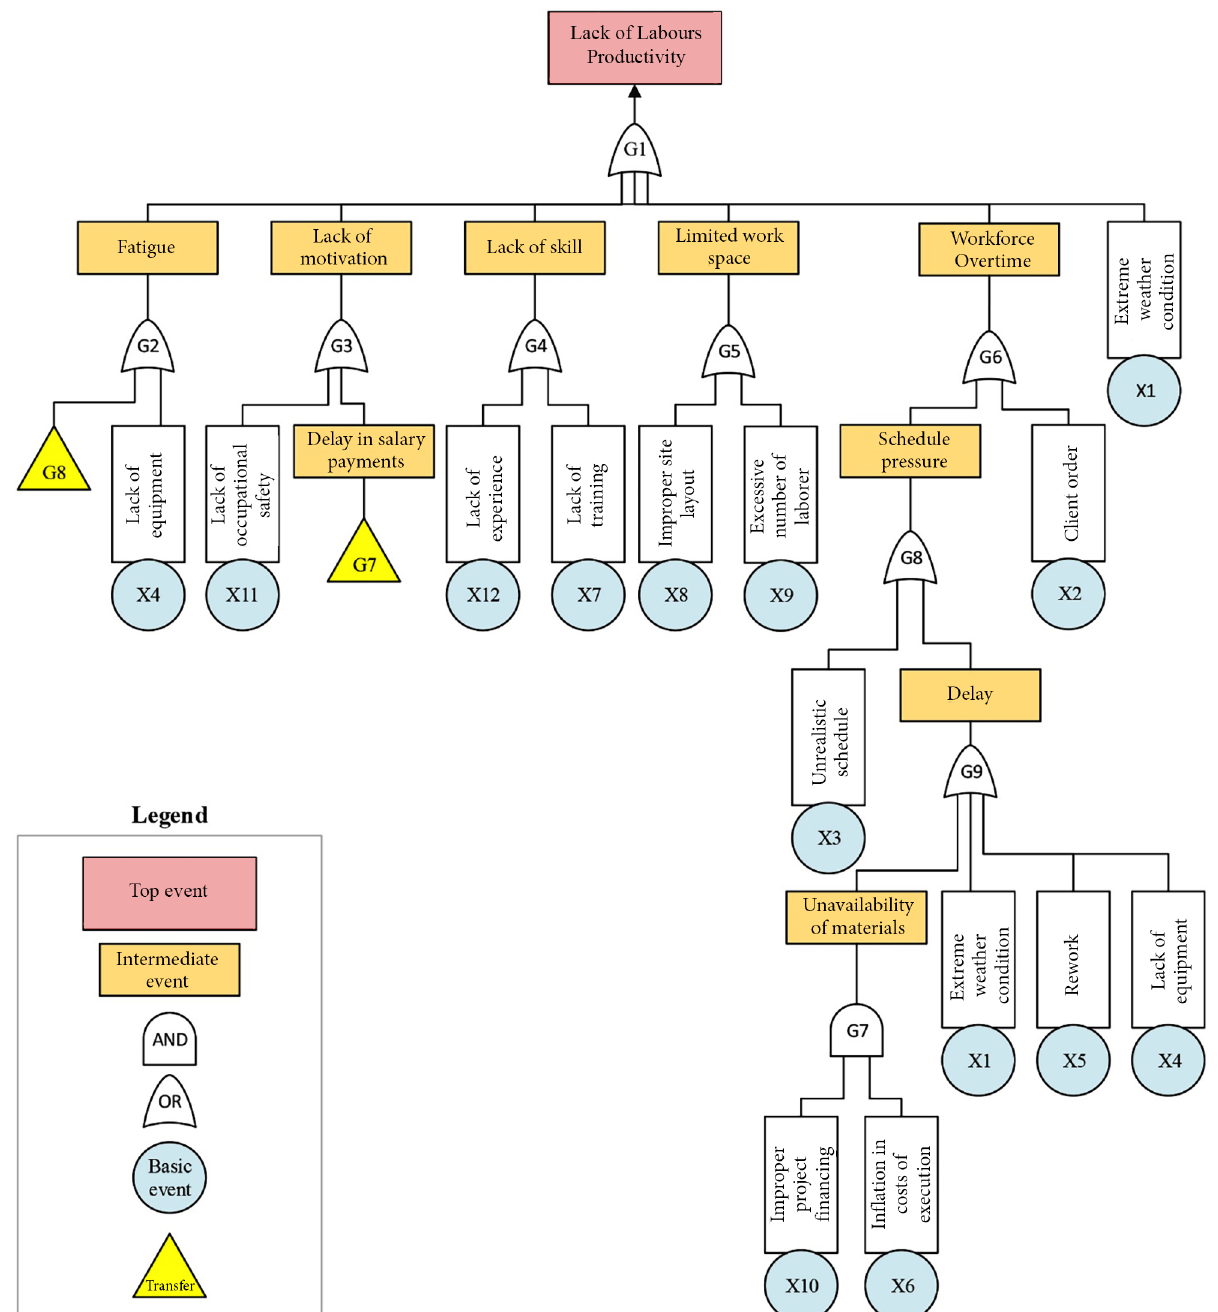
Figure 2. The fault tree structure of different events leading to the lack of labor